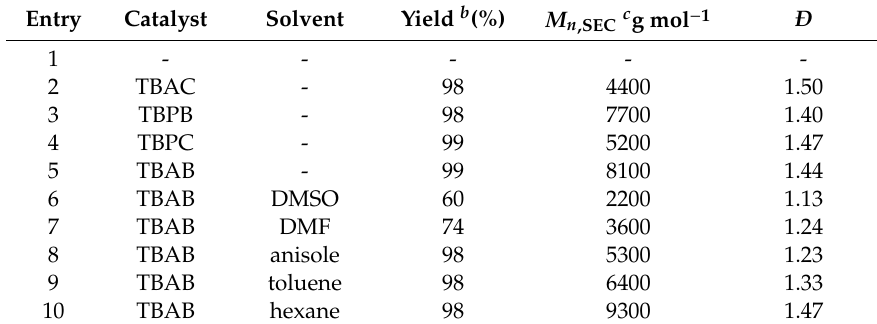
Optimization of the copolymerization condition of glycidyl phenyl ether ( GPE)